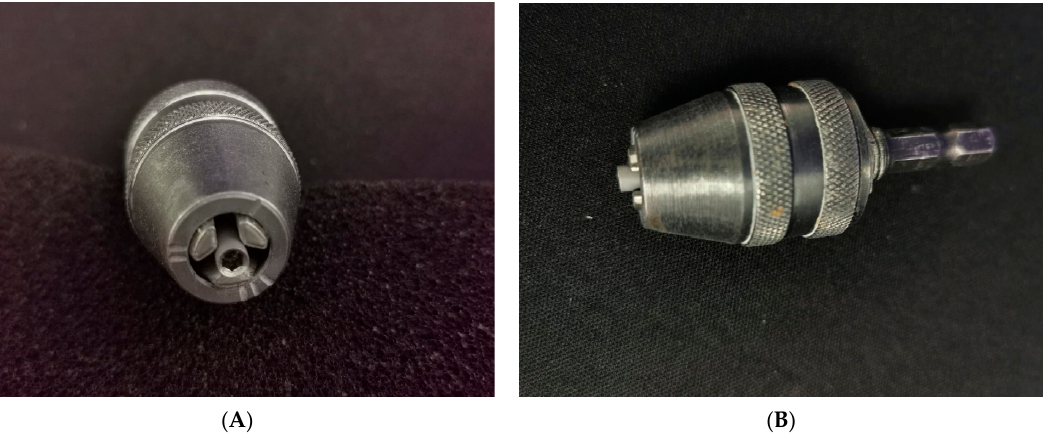
Figure 1. Transfer accessory—modified mandrel and implant analog: ( A ) frontal view; ( B ) lateral view.